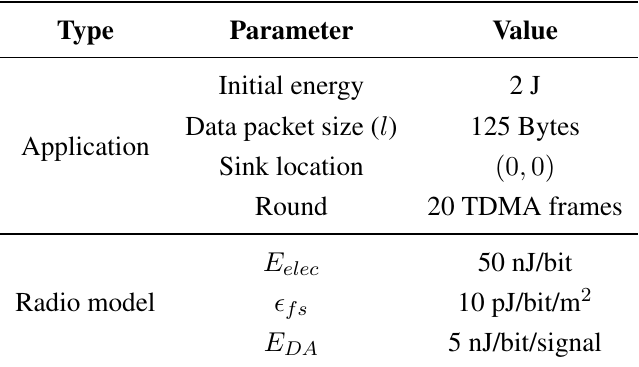
Table 2. Simulation